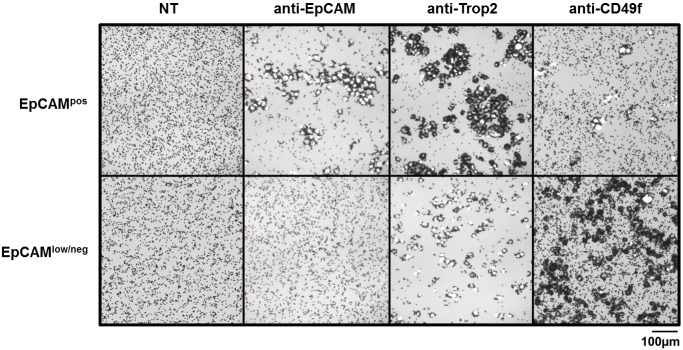
Enrichment of EpCAMpos/neg cells with Dynabeads.EpCAMpos (upper panel; MCF7, SKBR3, T47D, HCC1500 and ZR-75-1) and EpCAMlow/neg (lower panel; MDA-MB-231) cells were captured with Dynabeads coupled with antibodies for EpCAM, Trop2 and CD49f (1 μg ab/2.5x105 cells/1x107 beads). No cells bound to uncoated Dynabeads (NT = no target). Cells were imaged after a DAPI stain and are depicted as brightfield/DAPI merge; 10x magnification.